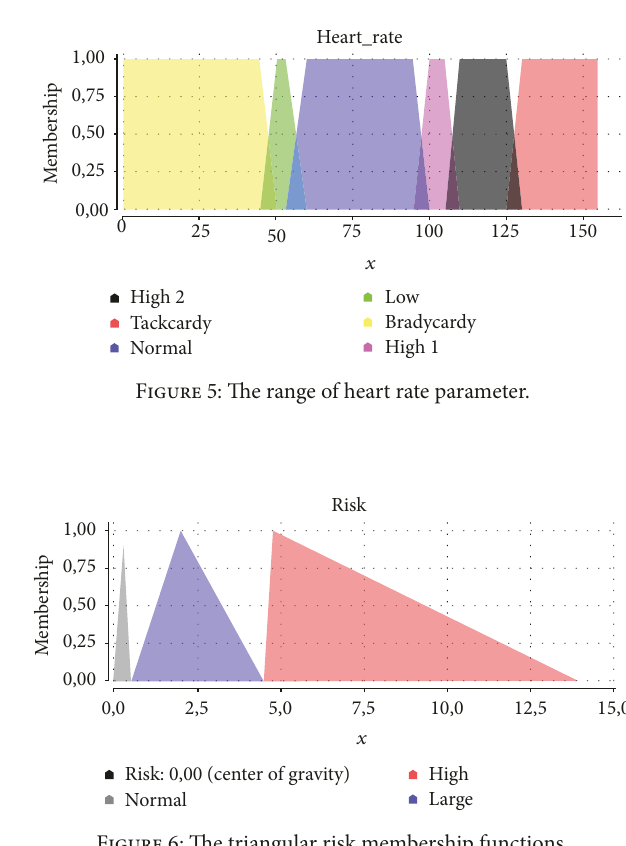
Figure 6: The triangular risk membership